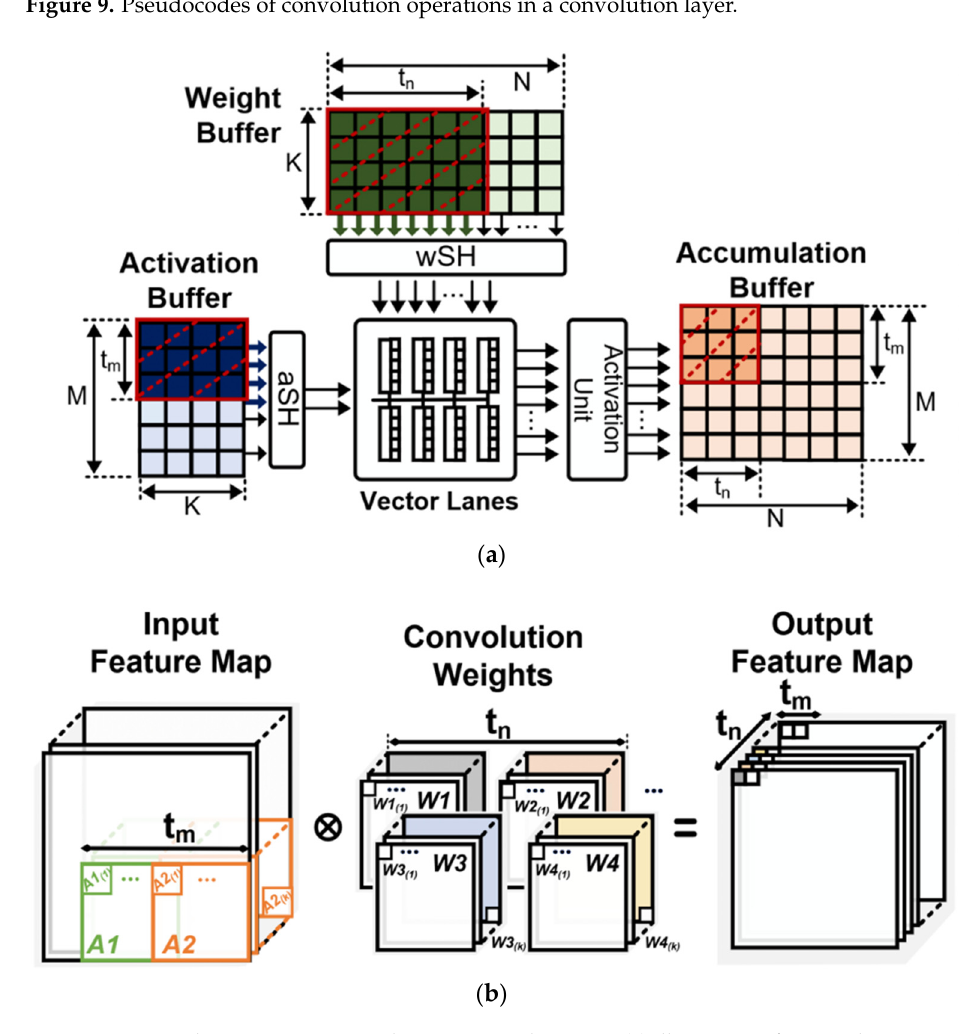
Figure 10. Convolution operation inside CONNA architecture: ( a ) Illustration of a convolution operation using matrix multiplication; ( b ) Convolution operation with t m activations and t n convolution kernels.